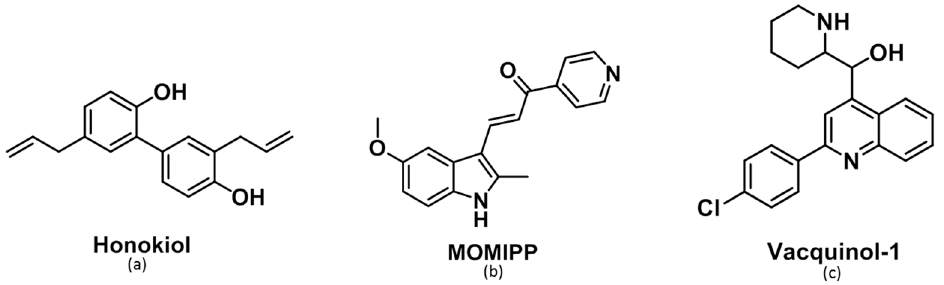
Figure 4. Chemical structure of the three compounds used in this study.